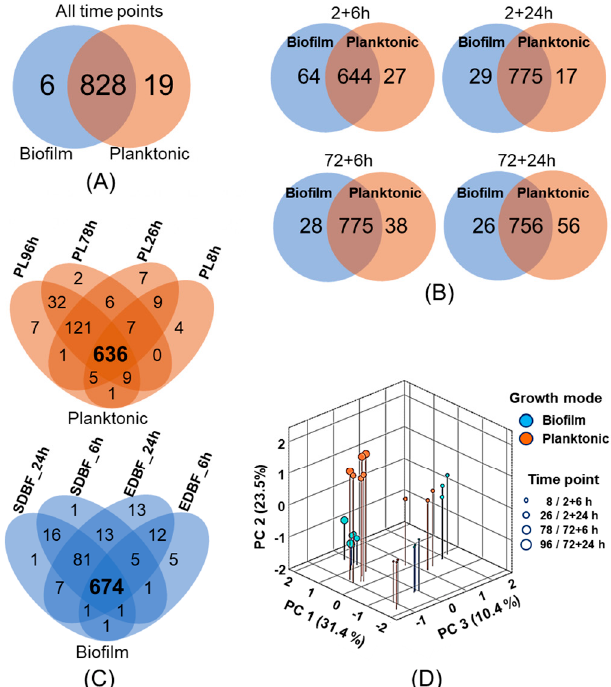
Figure 2. ( A ) Venn diagram comparing the number of all identified proteins from biofilm and planktonic cell surfaces. ( B ) Comparison of the number of specific and commonly identified proteins between the planktonic and biofilm cells at different time points of growth. ( C ) The specific and commonly identified proteins within planktonic and biofilm cell samples at different time points of growth. ( D ) 3D-PCA score plot (varimax rotation and Kaiser normalization) of the individual samples with 3 replicates each. An initial oblimin rotation with Kaiser normalization was pre-applied to verify the absence of intercomponent correlation (|r| ≤ 0.111 for all pairs).